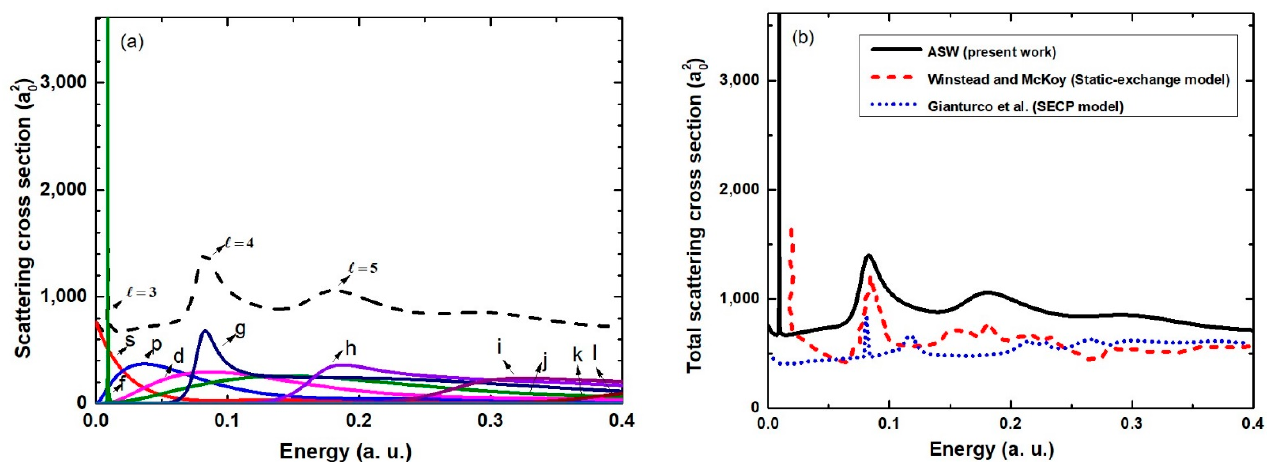
Figure 1. ( a ) Total (black dashed line) and partial cross-section of the e-C 60 elastic scattering; partial wave cross-sections and the resonances are labelled using arrows. ( b ) Total e-C 60 elastic scattering cross-section using ASW (black solid line) is compared with static-exchange model (red dashed line) [64], and SECP model (blue dotted line) [63].